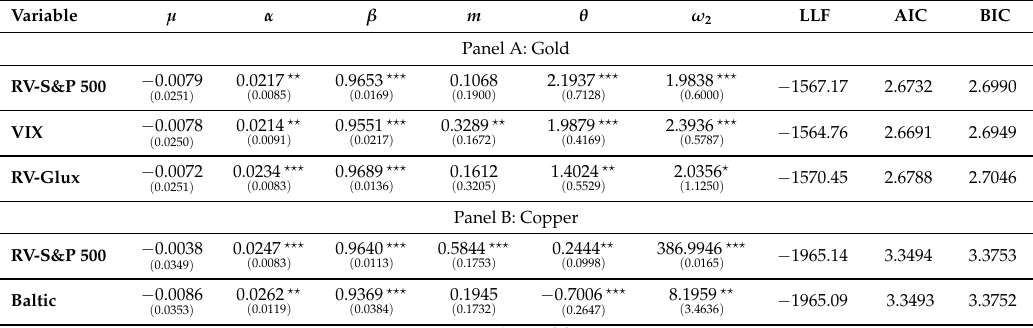
Table 6. GARCH-MIDAS for Gold and